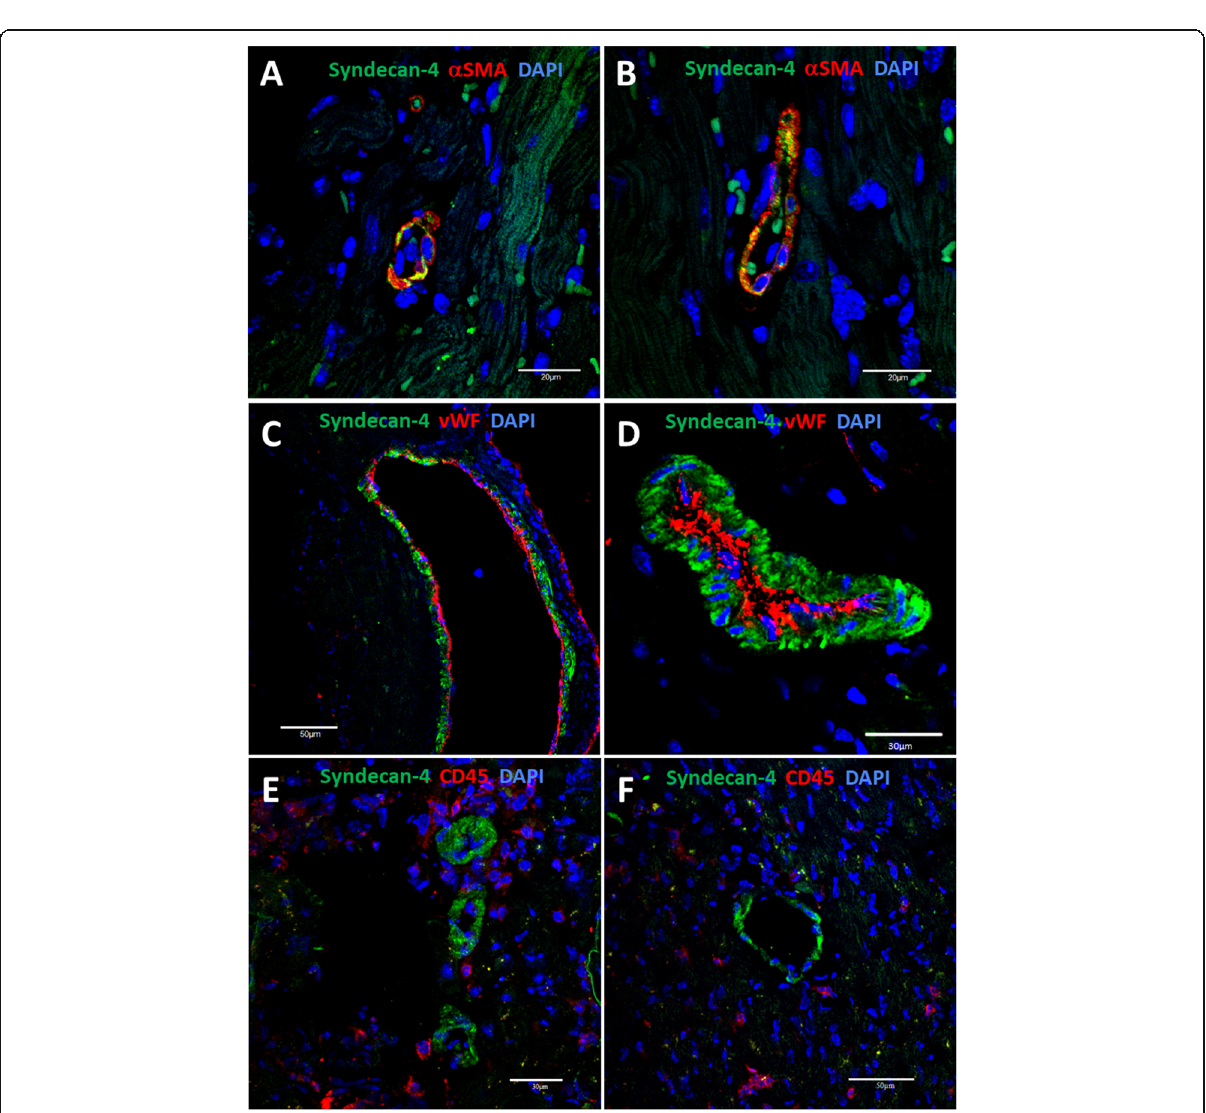
Fig. 3 Expression of syndecan-4 in endothelial cells, vascular smooth muscle cells. and leukocytes. Heart sections of mice 180 days after infection were stained with syndecan-4 and α -smooth muscle actin - α -SMA ( a and b ), von Willebrand factor - vWF ( c and d ) or CD45 ( e and f ). Sections were co-stained with DAPI and observed by confocal